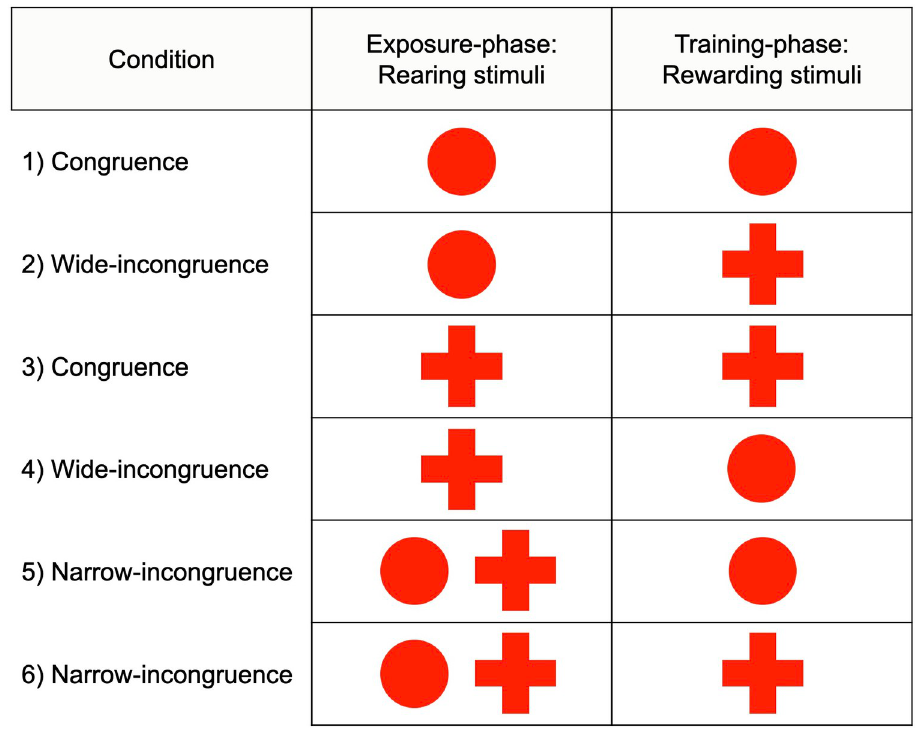
Fig 4. Overview of Experiment 2. Six experimental conditions were arranged: Reared full red disk-rewarded full red disk (“congruence”); reared full red disk-rewarded red cross (“wide-incongruence”); reared red cross-rewarded red cross (“congruence”); reared red cross-rewarded full red disk (“wide-incongruence”); reared mixed-rewarded full red disk (“narrow-incongruence”); reared mixed-rewarded red cross (“narrow-incongruence”). The two narrow- incongruence conditions relate to the original experimental design by Bateson and Chantrey